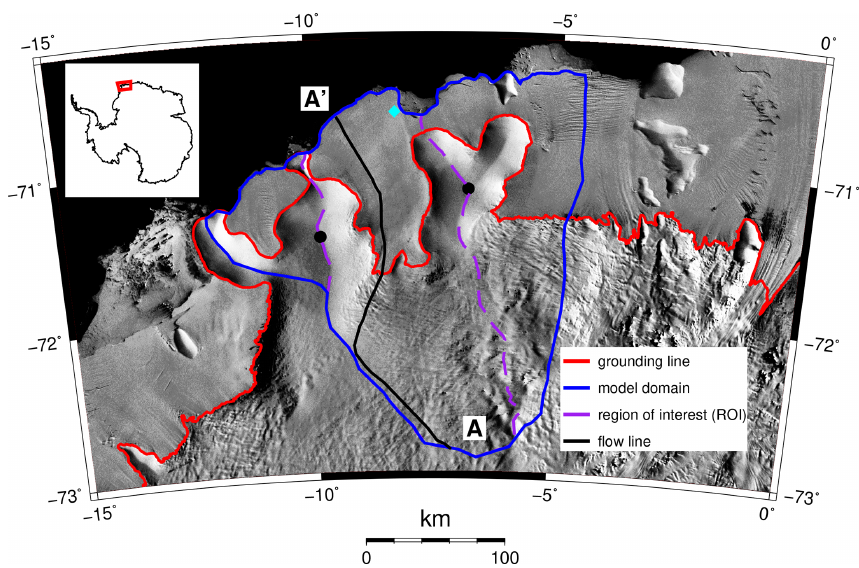
Figure 1. Overview of the Ekström Ice Shelf catchment with present-day grounding line (Bindschadler et al., 2011) and model domain. Cyan square shows location of Neumayer Station III. Filled black circles indicate location of ice rises. Flow line (A–A (cid:48) ) is shown in Fig. 10. Background is the MODIS Mosaic of Antarctica (Scambos et al.,